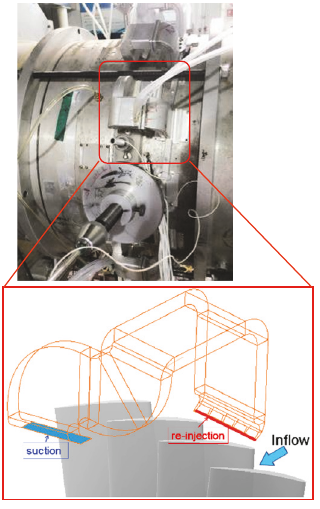
Figure18:Tipairrecirculationasameansofcasingtreatment([19]). Figure reproduced from NAN et al.